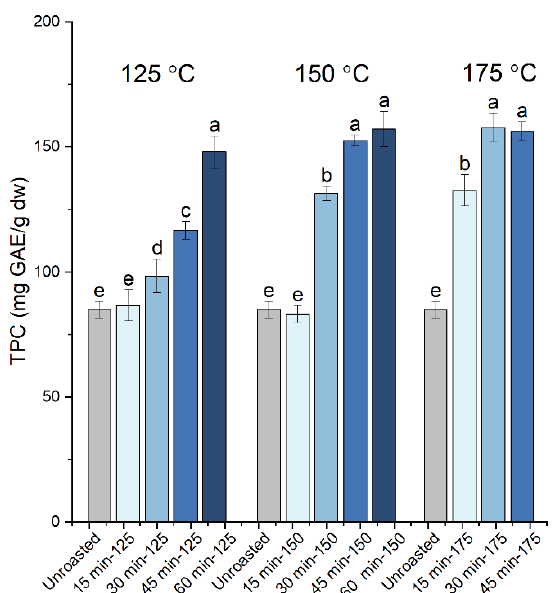
Figure 1. The total polyphenolic content (TPC) of the carob powder extracts obtained prior to (unroasted) and after the roasting of kibbles at 125 ◦ C (for 15, 30, 45 and 60 min), 150 ◦ C (for 15, 30, 45, 60 min) and 175 ◦ C (for 15, 30, 45 min). The different letters show the statistically significant differences according to Tukey’s honestly significant difference (HSD) test at p < 0.05. Table 1. Total polyphenolic content (TPC), proanthocyanidin content, gallic acid content, cinnamic acid content, EC 50 and Trolox equivalent antioxidant capacity (TEAC) values of the extracts from unroasted and roasted carob powder samples at the indicated roasting conditions.